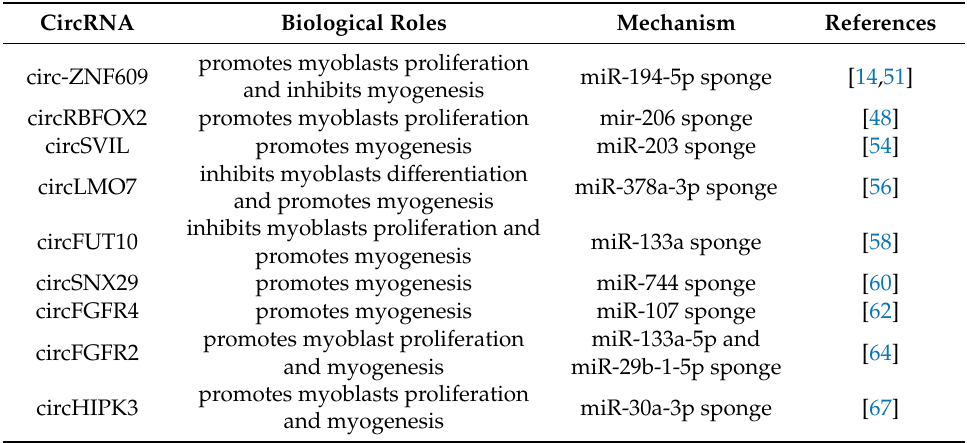
Table 2. CircRNAs involved in skeletal muscle